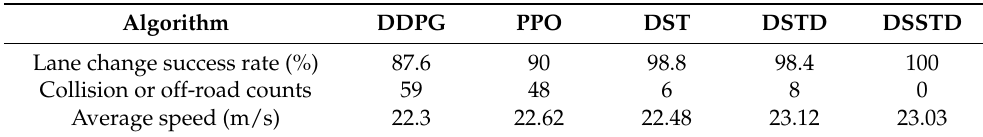
Table 4. Comparison of different methods in the test. Algorithm